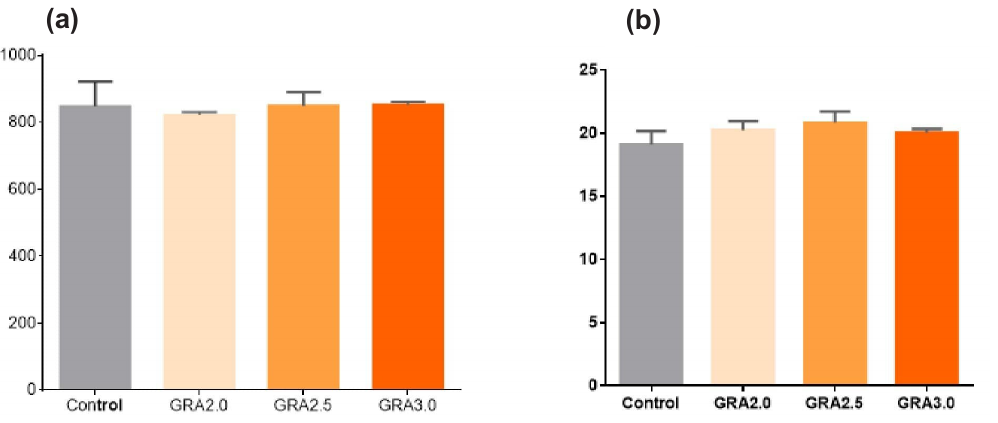
Figure 4: Data are means ± standard deviation (S.D.) based on one-way ANOVA followed by Tukey test ( n =4). No significant differences were detected ( p ≤0.05). (a) Average food consumption for the duration of the study (42 days). ( b) Daily average grams of food intake per animal. GRA: Granadilla at doses of 2.0, 2.5 and 3.0 g/L. No significant differences were detected for food